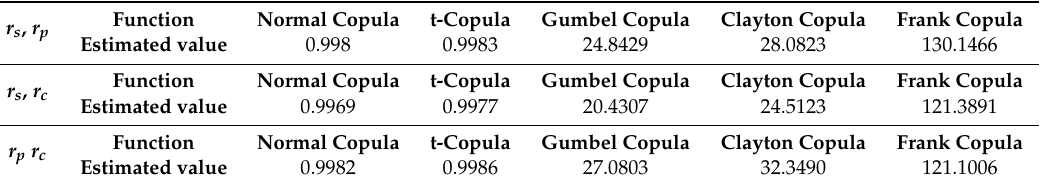
Table 3. Parameter estimation of the Copula function.